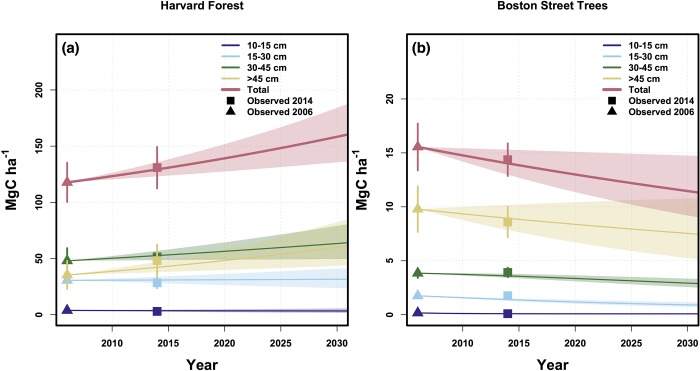
Projected C storage.Projected aboveground carbon pools at rural Harvard Forest (a) and in urban Boston street trees (b) between 2006 and 2030. Triangles represent 2006 observations ± 95% CI and squares represent 2014 observations ± 95% CI. Pools are broken up by size class with the total carbon storage represented in red. Models were run 1000 times and shaded polygons represent the middle 95% of model observations. Model structure and parameters can be found in S1 Fig.